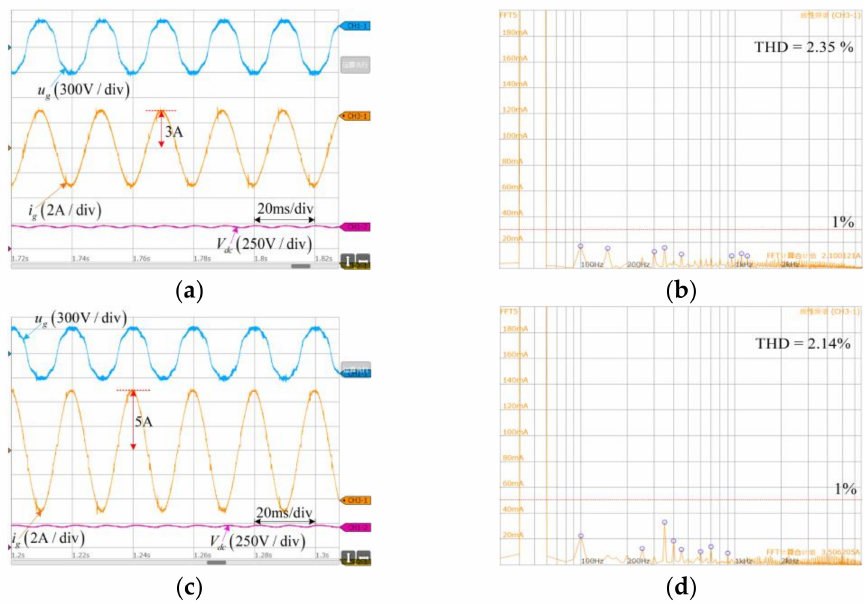
Figure 17. Experimental waveforms of proposed closed-loop controller. ( a , b ) Im is 3A, ( c , d ) Im is 5A. From Figure 17b,d, THDs of grid currents are 2.35% and 2.14%, respectively, and the 3rd, 5th, and 7th harmonic contents are all reduced below 1% under these two situations.